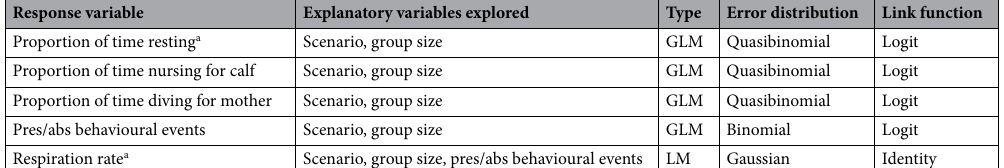
Table 2. Models used in analyses to test for behavioural effects of underwater electric and petrol engine vessel noise on pilot whales. Models used were linear models (LM) and generalised liner models (GLM). a Fitted for both mother and calf. The scenario was control, electric engine, and petrol engine vessel passes. Presence and absence (pres/abs) of behavioural events outlined in Table